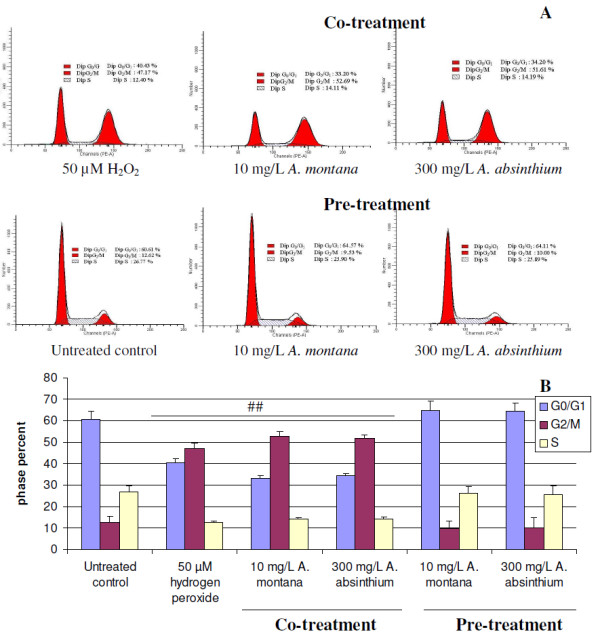
A Effect of plant extracts on cell cycle distribution of NCTC cells. Co-treated and pre-treated cells were stained with propidium iodide and analyzed by flow-cytometry. B DNA histograms analyzed by MODFITTM LT 3.0 software. Results are represented as mean ± SD (n = 6). Each phase of individual samples was compared with correspondent phase in untreated control using paired t-test. Statistically significant differences were observed (##p < 0.01).